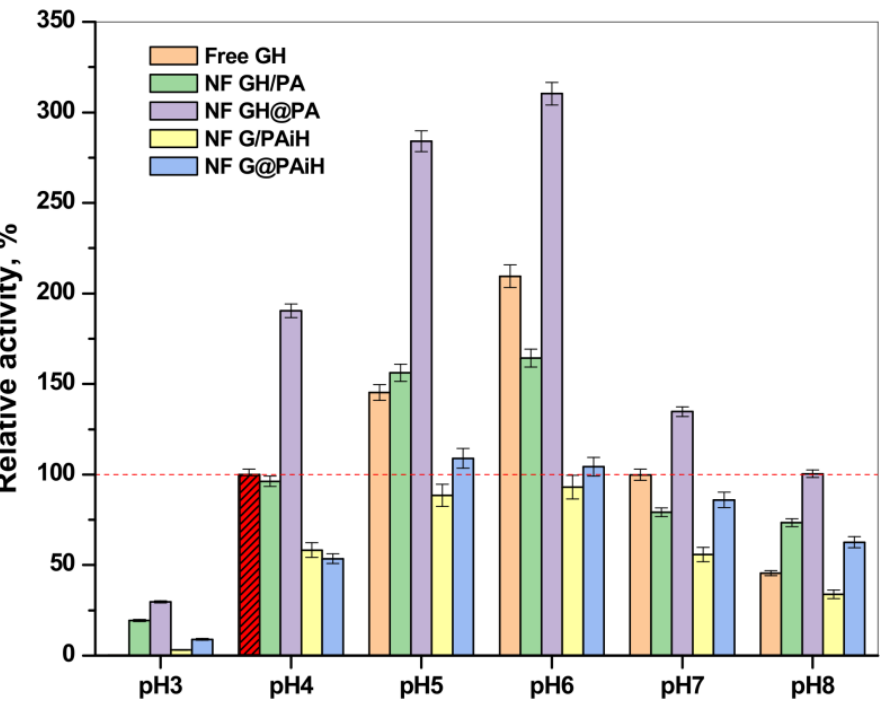
Figure 13. Relative activity of the PANF complexes measured at different pH values of the reaction medium. The activity of the free GOx/HRP systems at pH = 4 is taken as 100%. The NF GH&PA system displays its optimum activity in the same pH range; however, the relative activities reached 275% and 325% for pH values of 4 and 6, respectively. As in most of the previous tests, the systems with HRP immobilized in PA6 MP are less active than the free GOx/HRP system, whose highest values are of ca. 100% at pH = 4. The samples NF G/PAiH and NF G@PAiH, however, show 25% activity at pH = 3, at which the free enzymes become completely deactivated. Moreover, the NF G@PAiH system at pH = 8 performs even better than the free enzyme dyad. Apparently, at extreme pH values that pores becomes a dominant